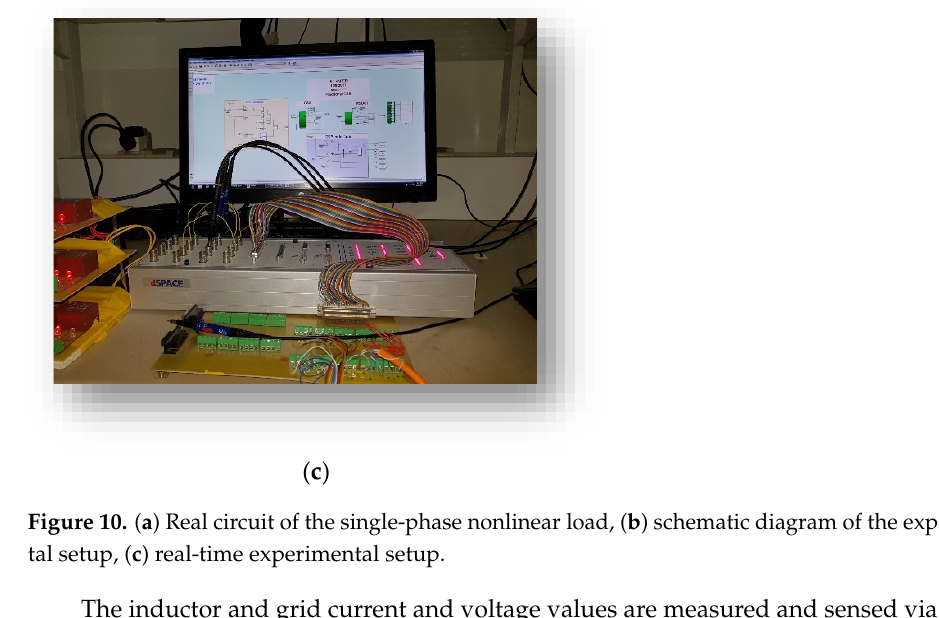
Figure 10. ( a ) Real circuit of the single-phase nonlinear load, ( b ) schematic diagram of the experi- mental setup, ( c ) real-time experimental setup.